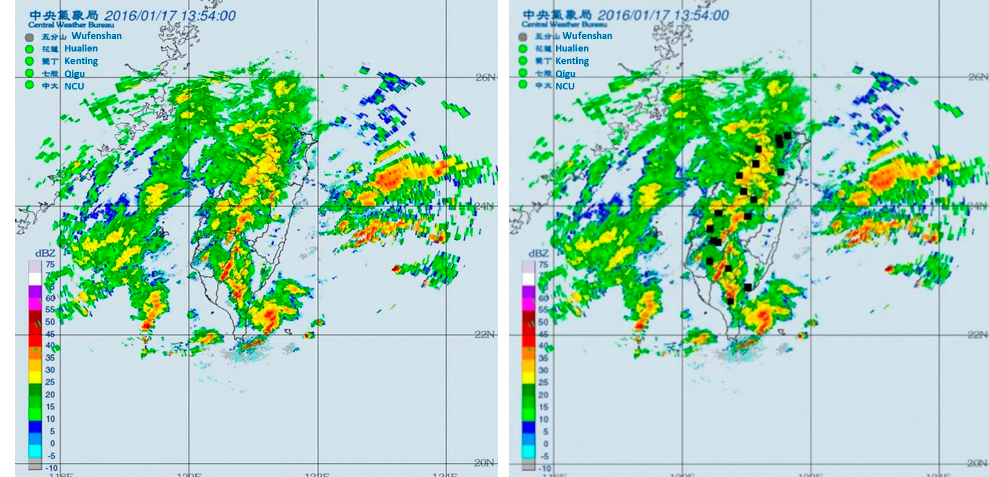
Figure 2. The calculation results of centroid based on the radar echo image. Left panel presents the input image. The position of the black spot in right panel denotes the estimated centroid position.